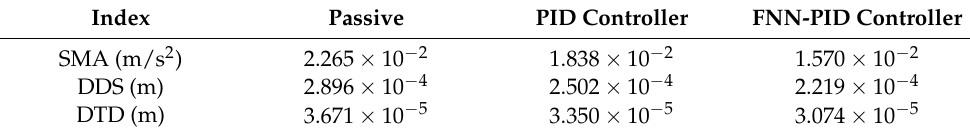
Table 3. Comparison of root-mean-square suspension performance under step excitation.